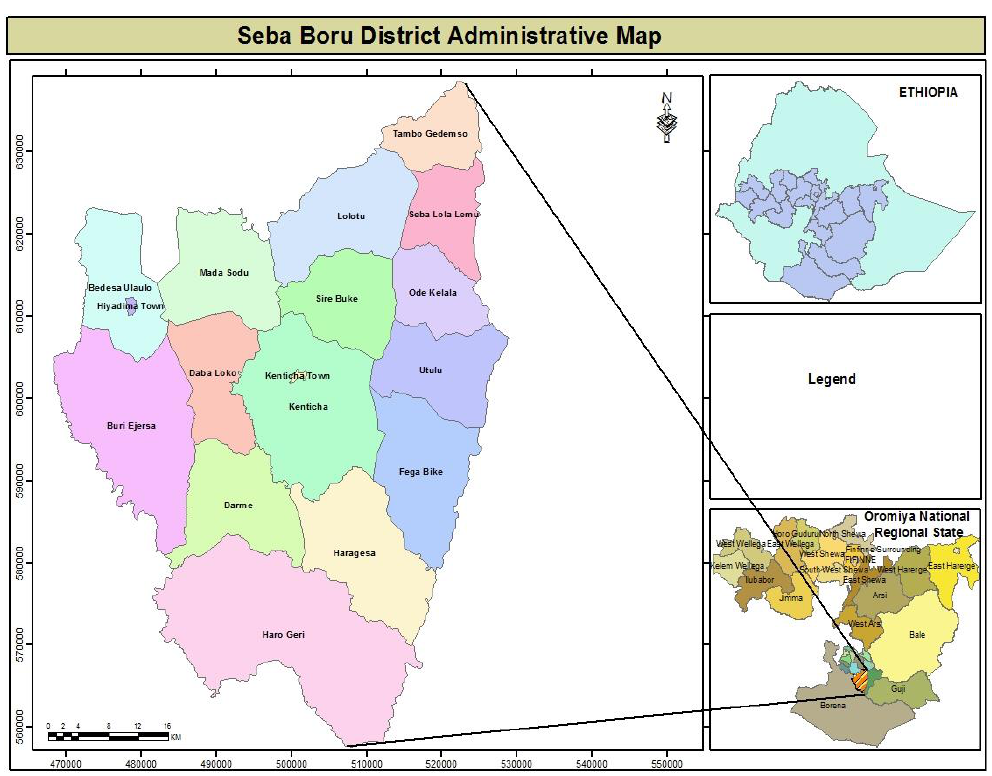
Figure 1. Map of the study area